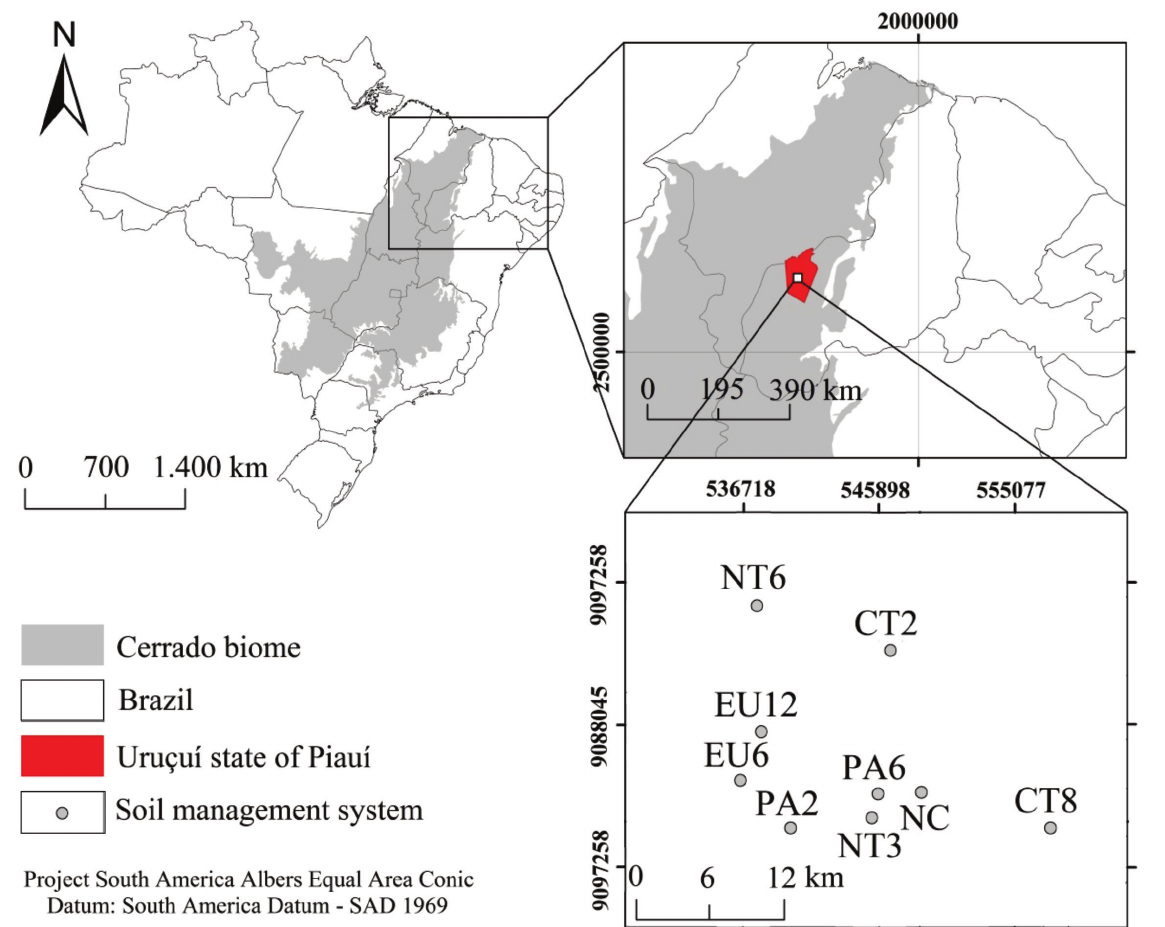
Figure 1. Location of study area, Urúcuí municipality in the state of Piauí, Brazil. Soil management systems: NC – Native Cerrado, EU6 – Six year Eucalyptus, EU6 - Twelve years Eucalyptus, PA2 – Pasture (two years), PA6 – Pasture (six years), CT2 – Conventional tillage (two years), CT8 – Conventional tillage (eight years), NT3 – No-tillage (three years), NT6 – No-tillage (six